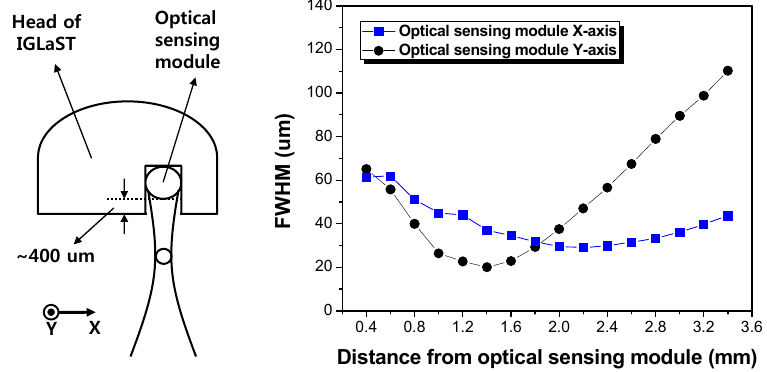
Figure 5. Beam diameter (FWHM) of the optical sensing module.